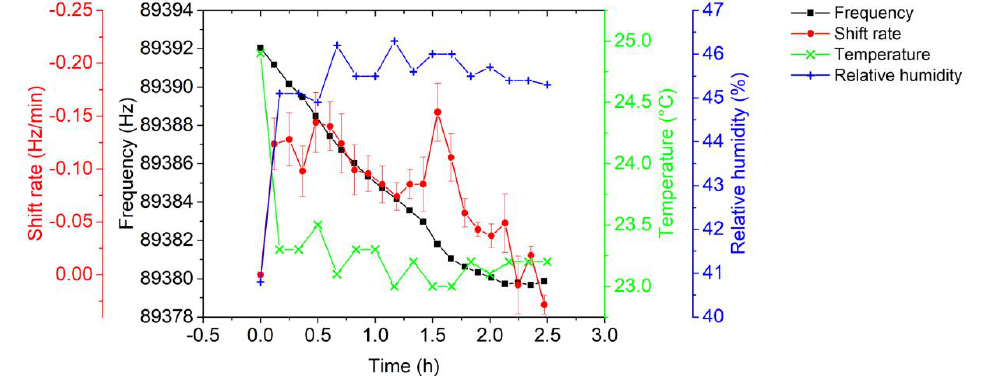
Figure 14. Decrement in resonance frequency (taken at a phase of 72°) and the corresponding frequency shift rate at t CT ≈ 7 min and ambient conditions ( T = 23.3 ± 0.23 °C; rH = 45.3 ± 0.63%).